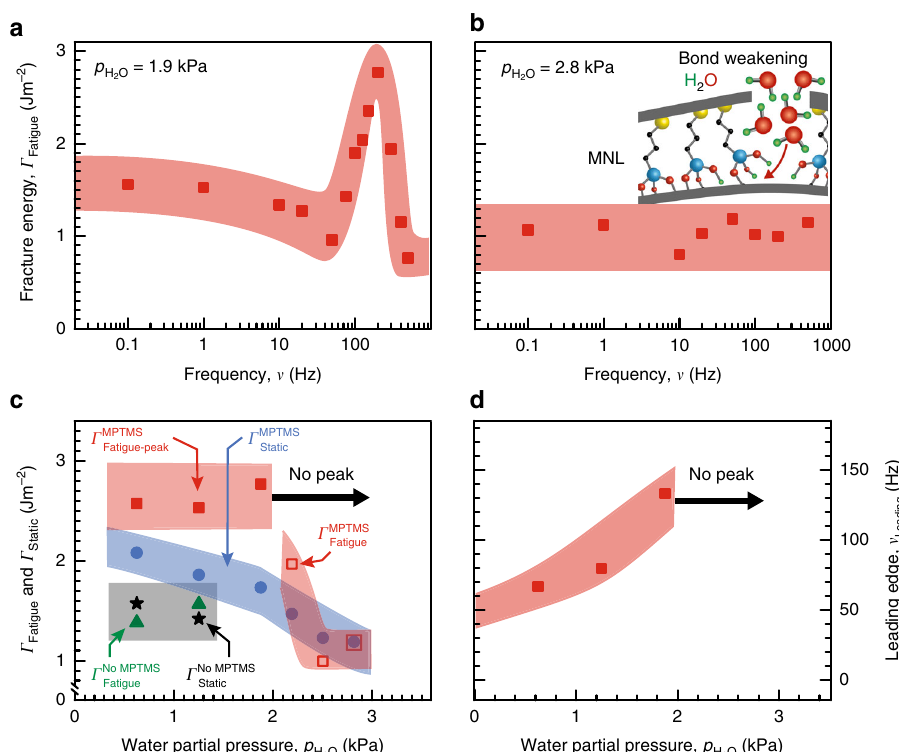
Fig. 2 Effect of moisture-dependent interfacial bond strength on fatigue toughening. Fatigue fracture energy Γ Fatigue of polymer-metal-ceramic structures with Cu-MPTMS-SiO 2 interfaces shown for water partial pressures a p squares) and average Γ Static (blue circles) plotted versus p (black stars) for stacks without MPTMS are also shown. There is no observable Γ Fatigue peak for p frequency ν Leading of the Γ Fatigue peak for Cu-MPTMS-SiO 2 interfaces. No Γ Fatigue peak is observed for p three tests. The width of the bands, drawn through the data points to guide the eye, connote the experimental uncertainty measured as standard